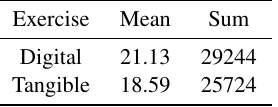
Table 1: Highest mean, maximum, and summed water depths (ft)